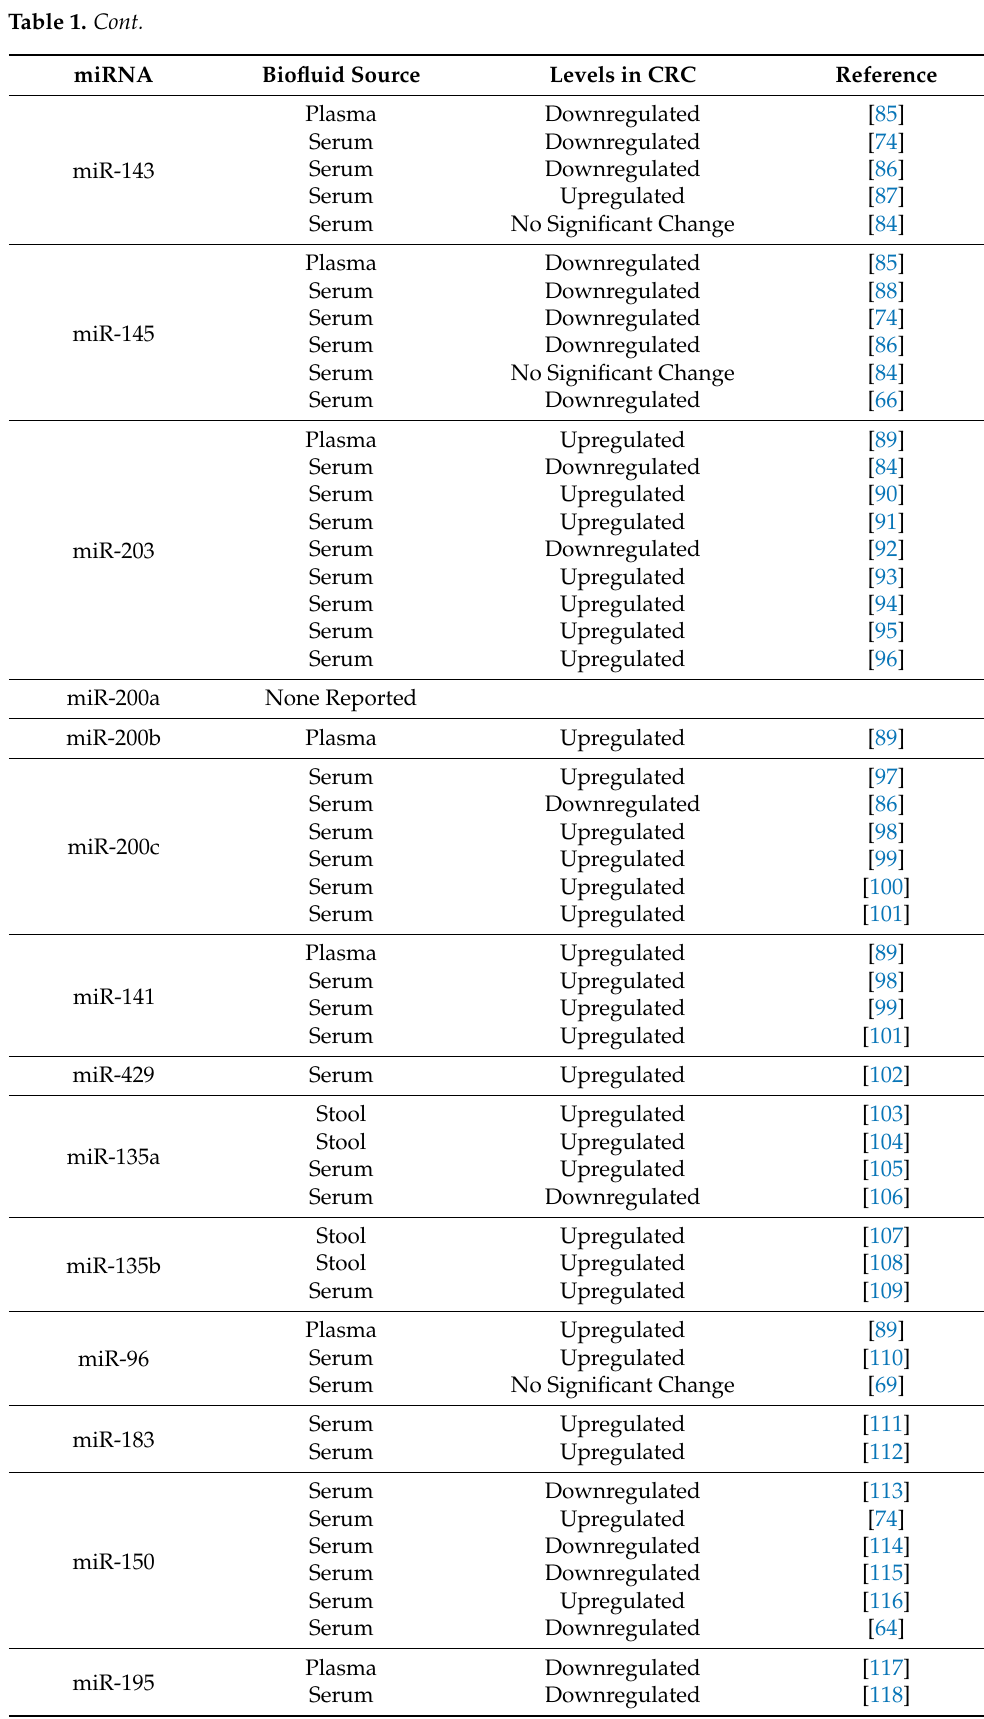
Table 1. Cont. miRNA Biofluid